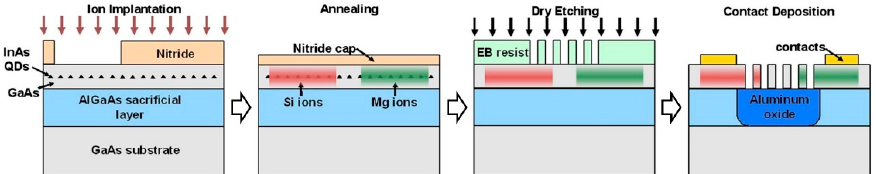
Figure 5. Lateral current injection in PhC nanocavity. Fabrication schematics of patterned ion implantation doping for the lateral p - i - n junction structure. Spatially targeted implantation of Si and Mg ions on the GaAs slab including InAs QDs via silicon nitride patterning mask (left). Dopant activation through thermal treatment and aligned definition of PhC nanocavities to form a lateral p - i - n structure using e-beam lithography and dry etching steps (middle). Contact metallization and oxidation of sacrificial layer underneath the PhC nanocavities (right) [31]. Figure reproduced with permission from American Institute of Physics.